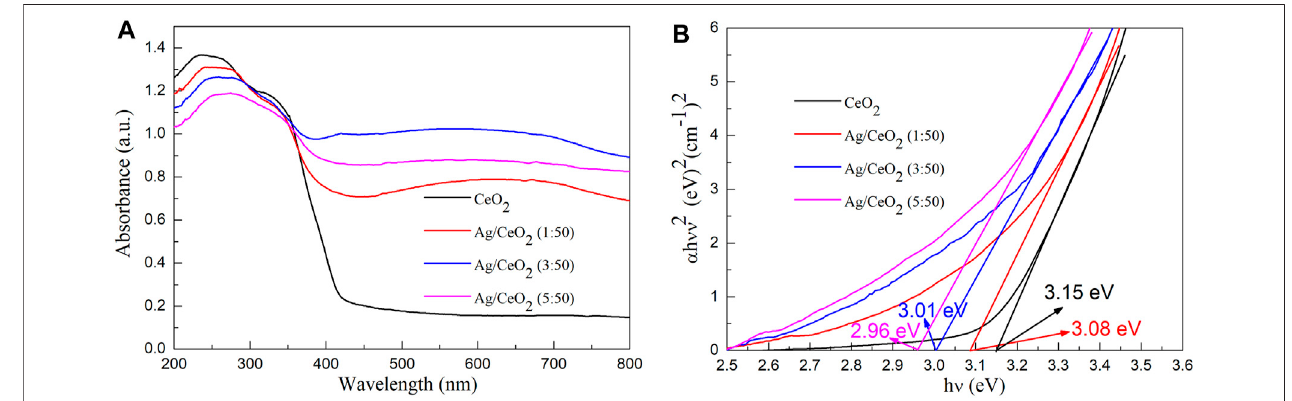
FIGURE 7 | (A) UV-Vis diffuse scattering spectra of pure cerium dioxide nano fi ber membranes and cerium dioxide nano fi ber membranes doped with different amountsofnano-silver. (B) Theopticalbandgap(Eg)valuesofpureceriumdioxidenano fi bermembranesandceriumdioxidenano fi bermembranesdopedwithdifferent amounts of nano-silver.